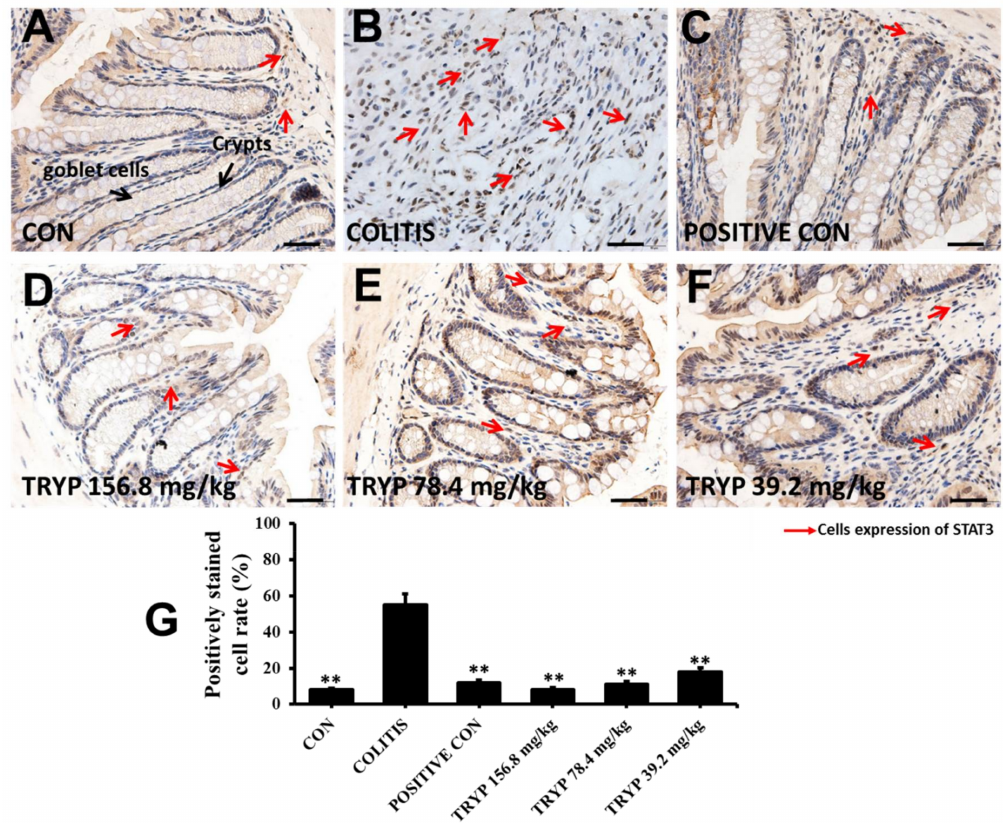
Figure 6. Treatment with TRYP suppressed the expression of p -STAT3, magnification × 400. ( A ) Immunohistochemistry result of control group with expressing p -STAT3 only. ( B ) The expression level of p -STAT3 increased sharply and both crypts and goblet cells disappeared. ( C ) Immunohistochemistry result of sulfasalazine control. ( D – F ) The expression level of p -STAT3 with different concentrations of TRYP treatment. ( G ) The column heights represented the positively stained cell rates. Error bars represented means ± SEM of n = 3, ** p < 0.01 compared with